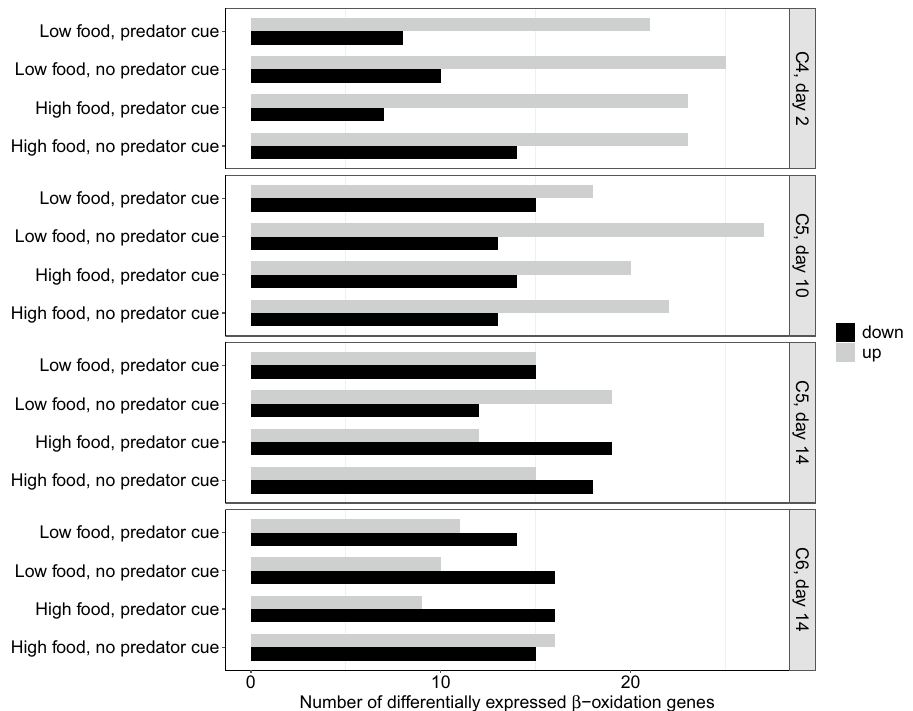
Figure 3. Number of significant (P < 0.05) differentially expressed ß-oxidation genes (x-axis) in Calanus finmarchicus in the experimental treatments (y-axis, left) each sampling day (y-axis, right) compared with the reference group ( Calanus spp. C5 copepodites in diapause). Number of upregulated genes declined with time (linear regression, P = 0.005, F 6,9 = 11.27, adjusted R 2 = 0.80). Stages (C4, C5 and C6) were assessed separately. Grey bars indicate upregulated genes and black bars indicate downregulated genes relative to the reference group. One gene upregulated in e.g. Lo + P also implies that the same one gene is correspondingly downregulated in the reference